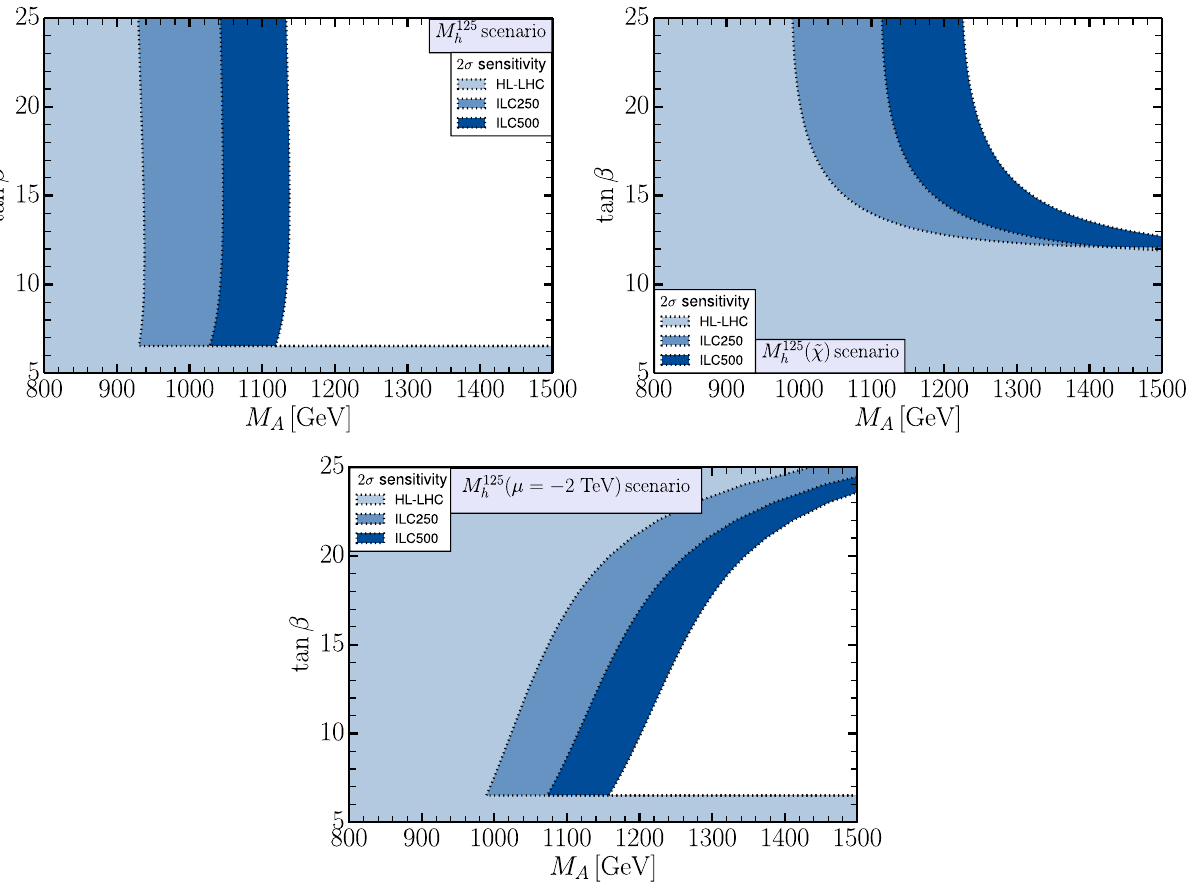
Fig. 7 Prospective 2 σ indirect exclusion region from Higgs rate measurements at the HL-LHC and the ILC, assuming agreement with the SM ( ˜ χ) scenario (upper right panel), and the M 125 ,μ − predictions, in the M 125 scenario (upper left panel), the M 125 h h